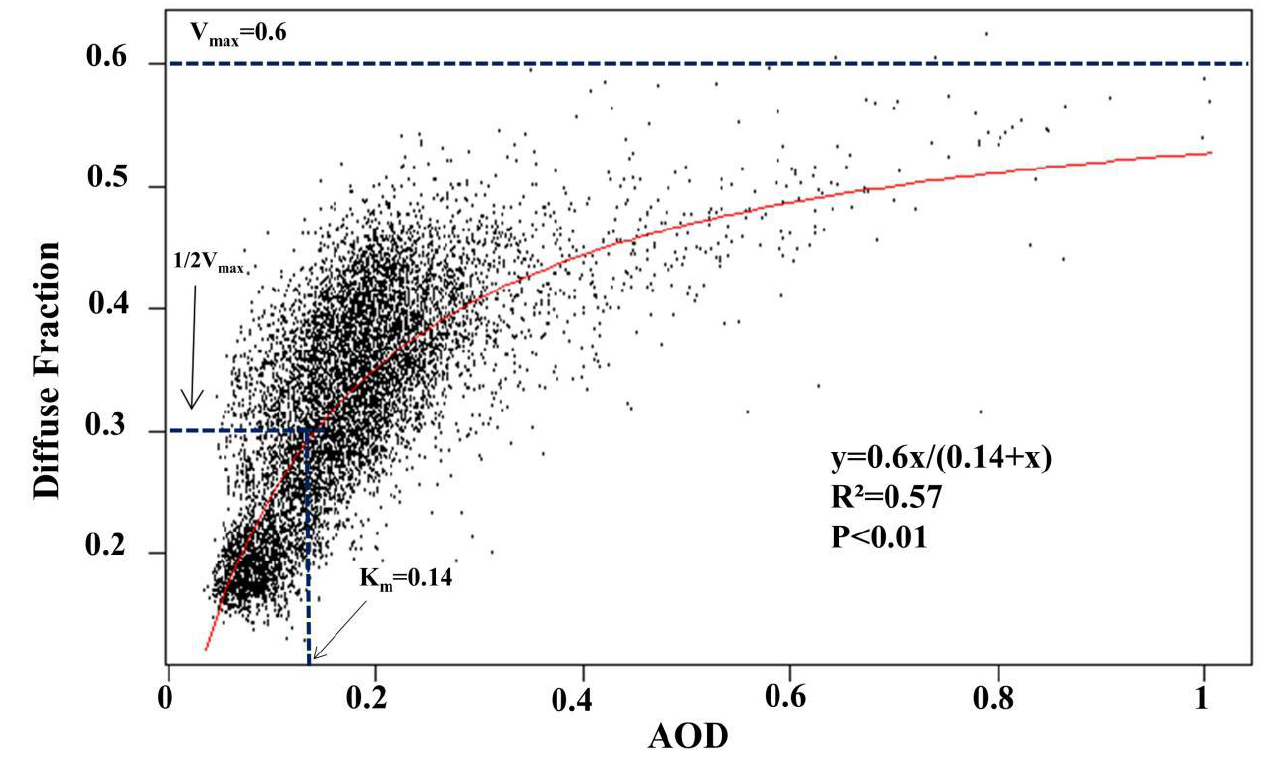
Figure 4. Scatter plot of daily diffuse fraction (D f ) and daily AOD of flux tower sites globally. The red line is fitted by the Michaelis–Menten equation in clear sky. V max represents the maximum D f , and K m represents the AOD value at half of the maximum D f .